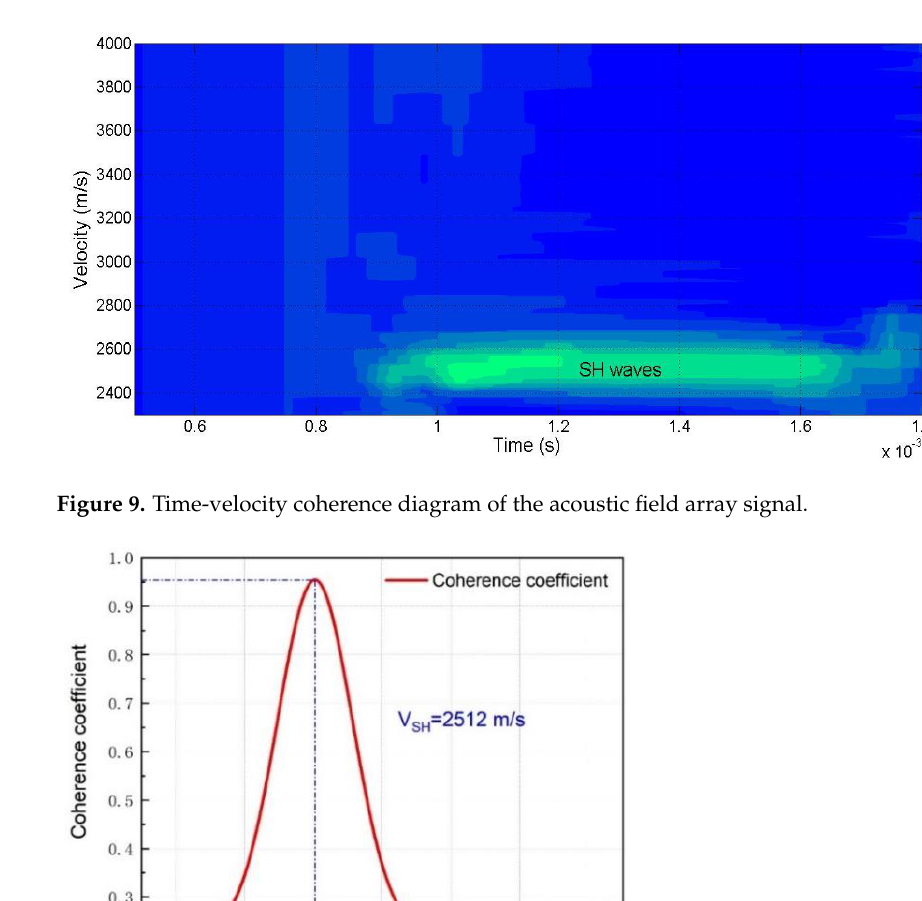
Figure 9. Time-velocity coherence diagram of the acoustic field array signal.